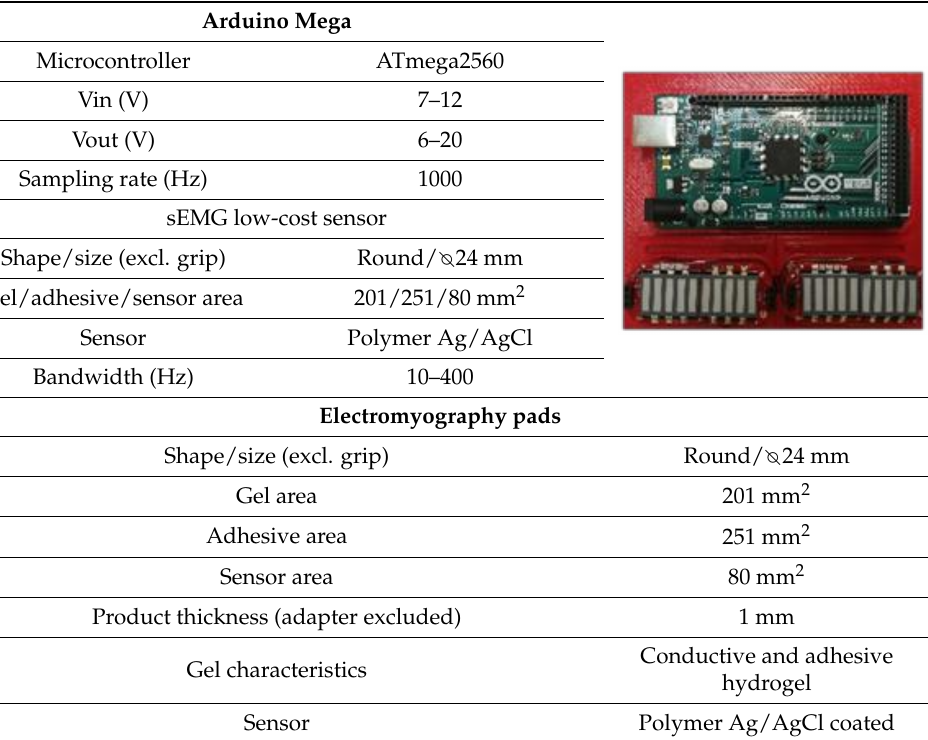
Table 1. Technical information of the sEMG device and the electromyography pads.